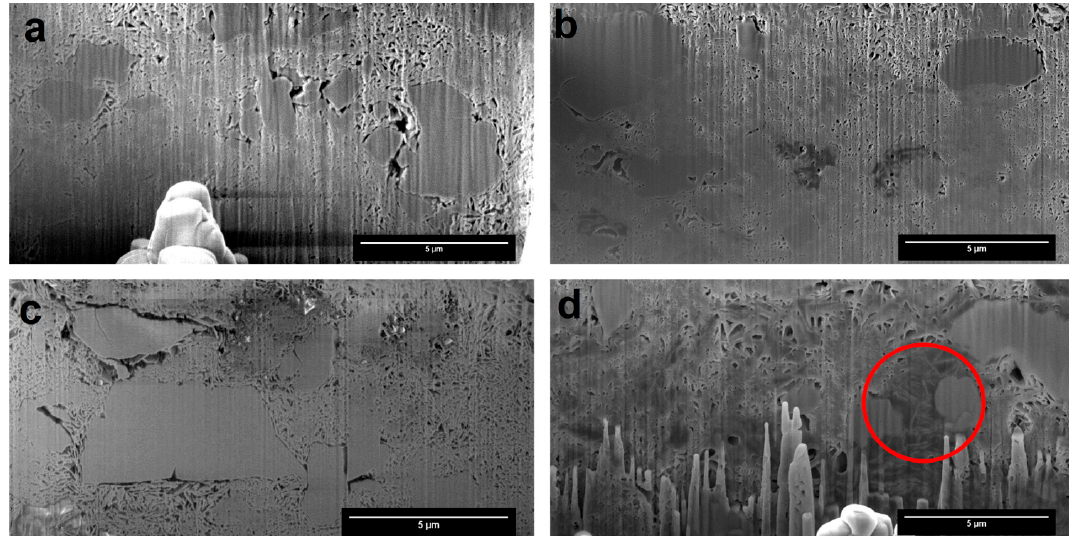
Figure 5. The focused ion beam scanning electron microscopy (FIB-SEM) images showed cross-sections of the formulations after consolidating the powder. ( a ) Pure FCC, ( b ) Nif-FCC without phospholipid, ( c ) D5N20, and ( d ) D20N20. The red circle shows an example of a region with blocked pores.